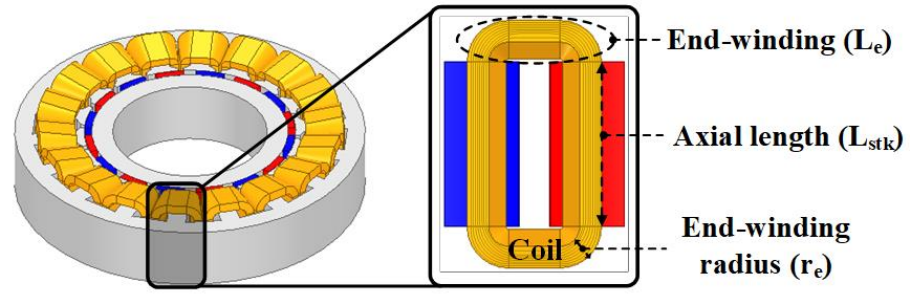
Figure 9. Conceptual diagram for calculating phase resistance.